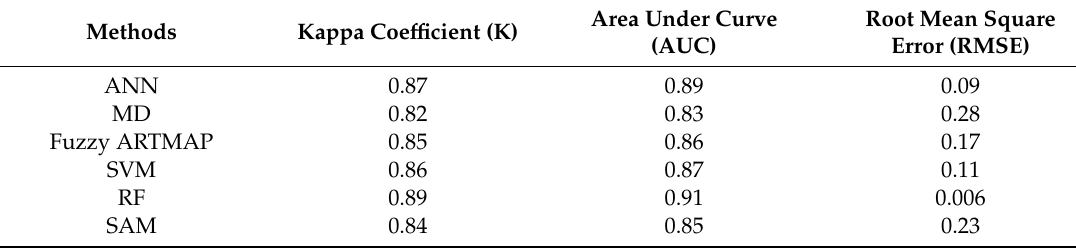
Table 5. Overall accuracy level of the classifiers used in this